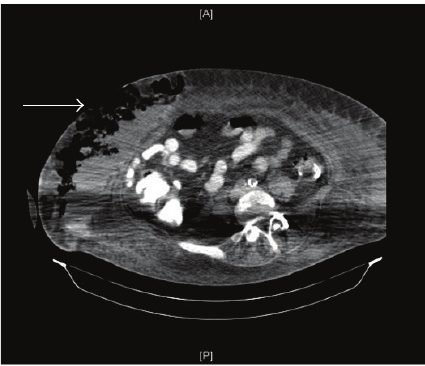
Figure 1: Anterior abdominal wall showing edema, erythema, and ruptured bullae over the abdomen.